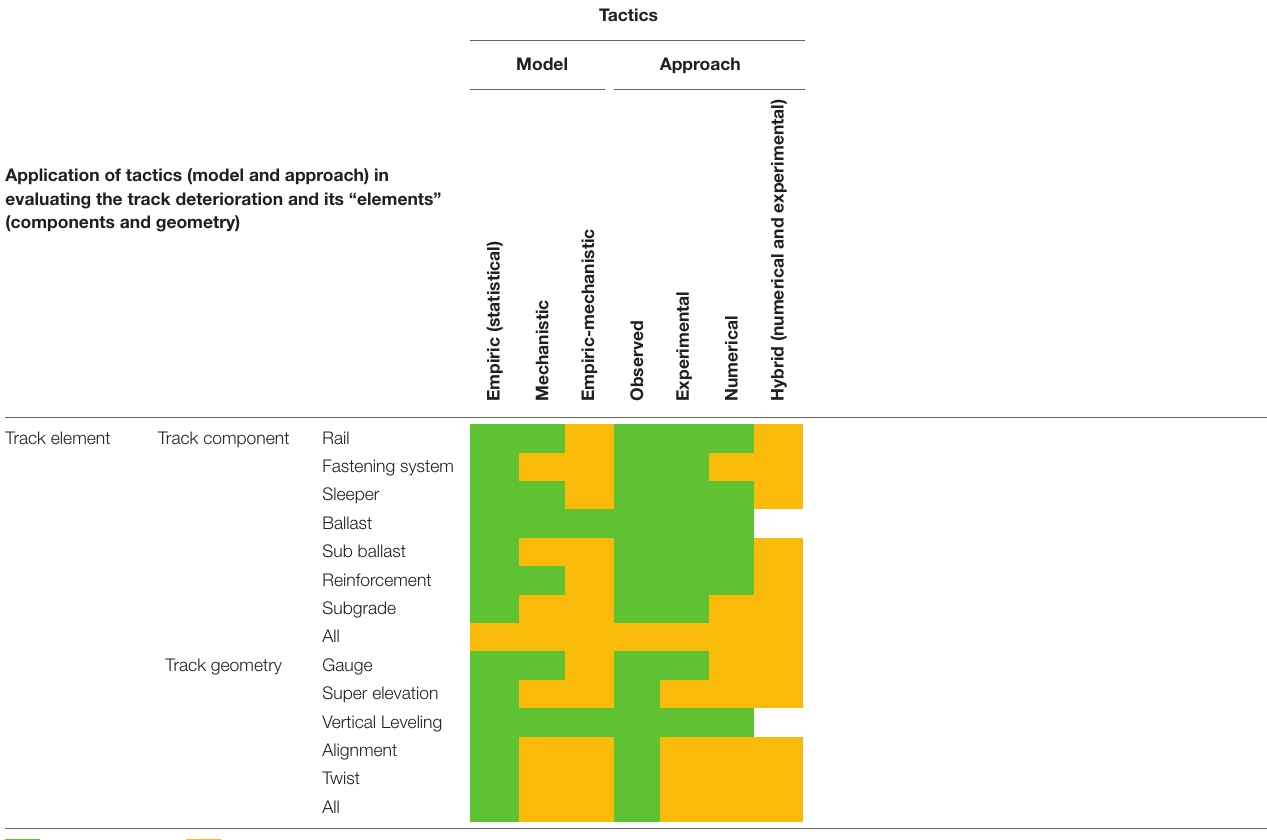
Application of tactics (model and approach) in evaluating the track deterioration and its “elements” (components and